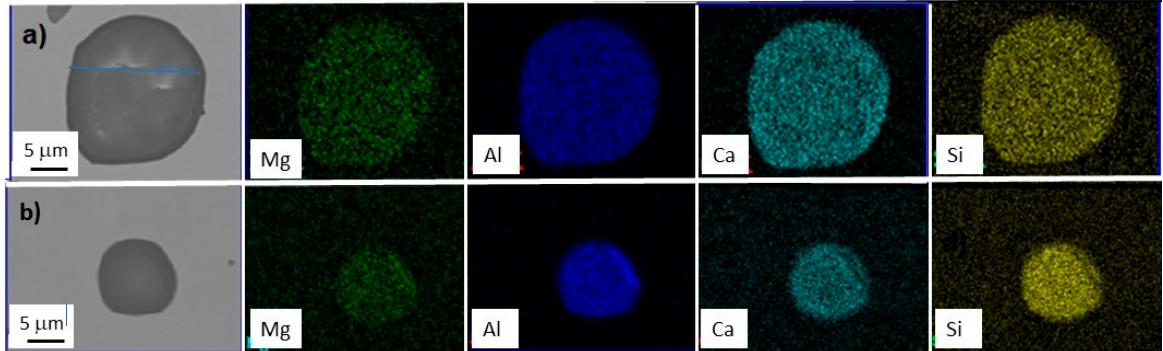
Figure 7. Elemental mapping for SiO 2 -Al 2 O 3 -CaO-MgO inclusions of different sizes: ( a ) 20 μ m and ( b ) 12 μ m.